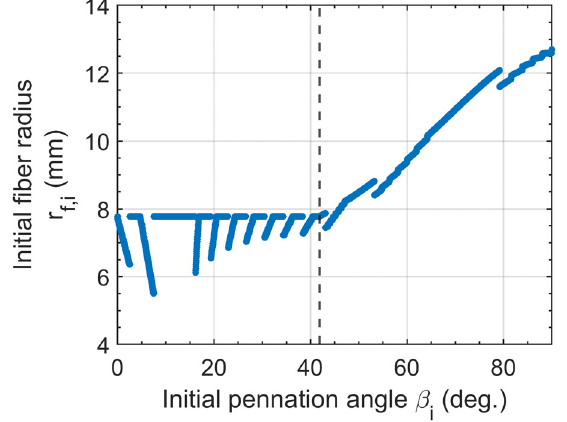
Figure 14. Variation in initial fiber radius with initial pennation angle with the pinned boundary condition. The dashed vertical line indicates the boundary between fiber contraction-limited (left of the line) and fiber rotation-limited (right of line) topologies.